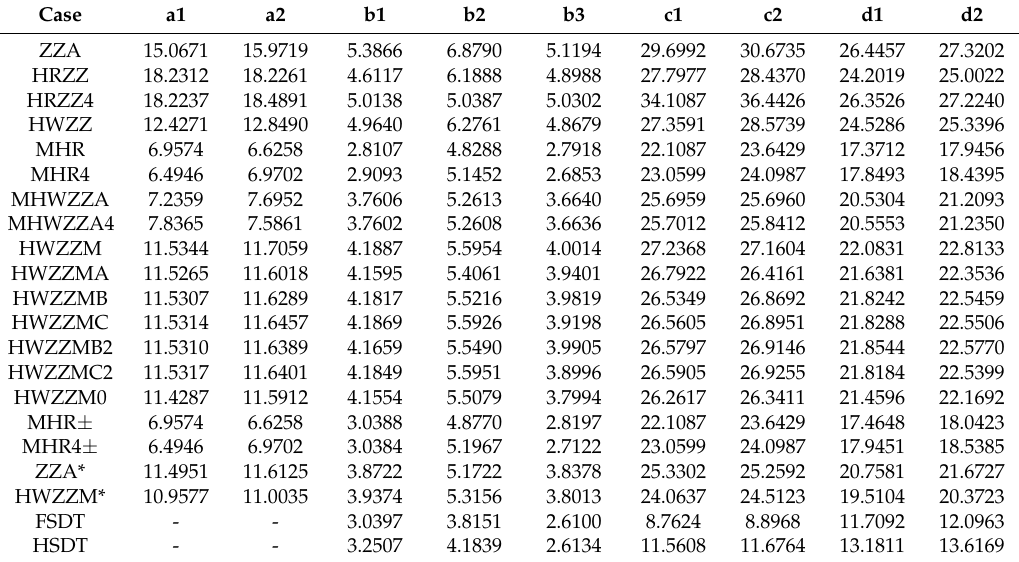
Table 21. Processing